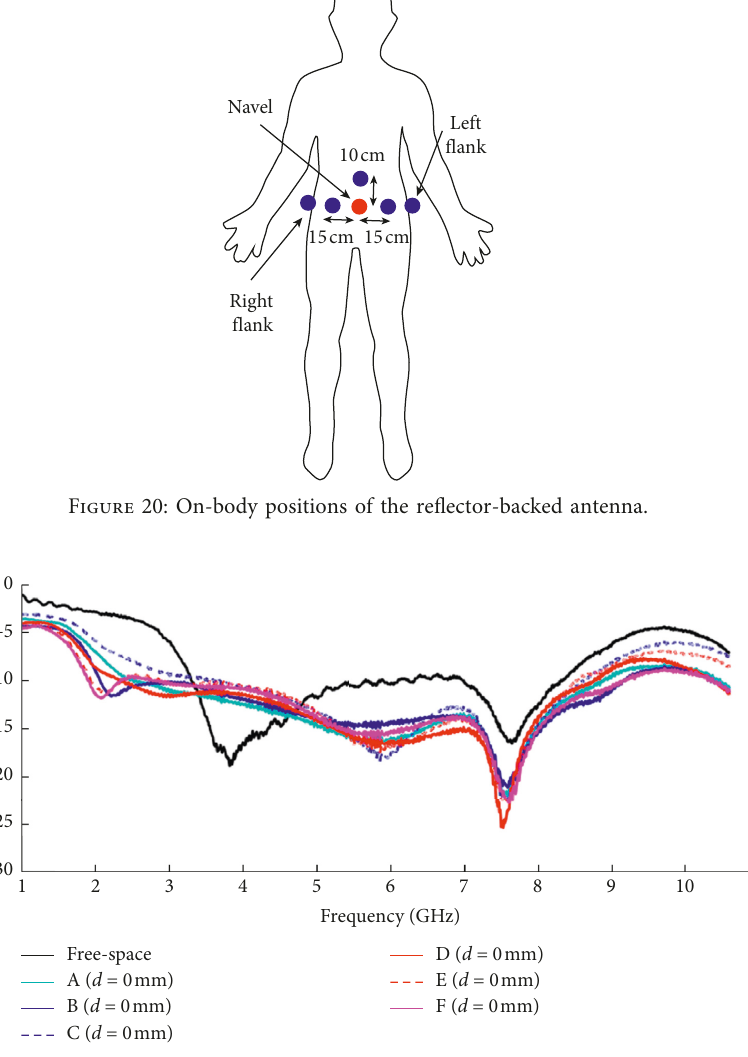
Figure 21: Measured on-body reflection coefficient of the proposed antenna for d � 0 mm. Table 7: Bandwidth values for different on-body positions. On-body